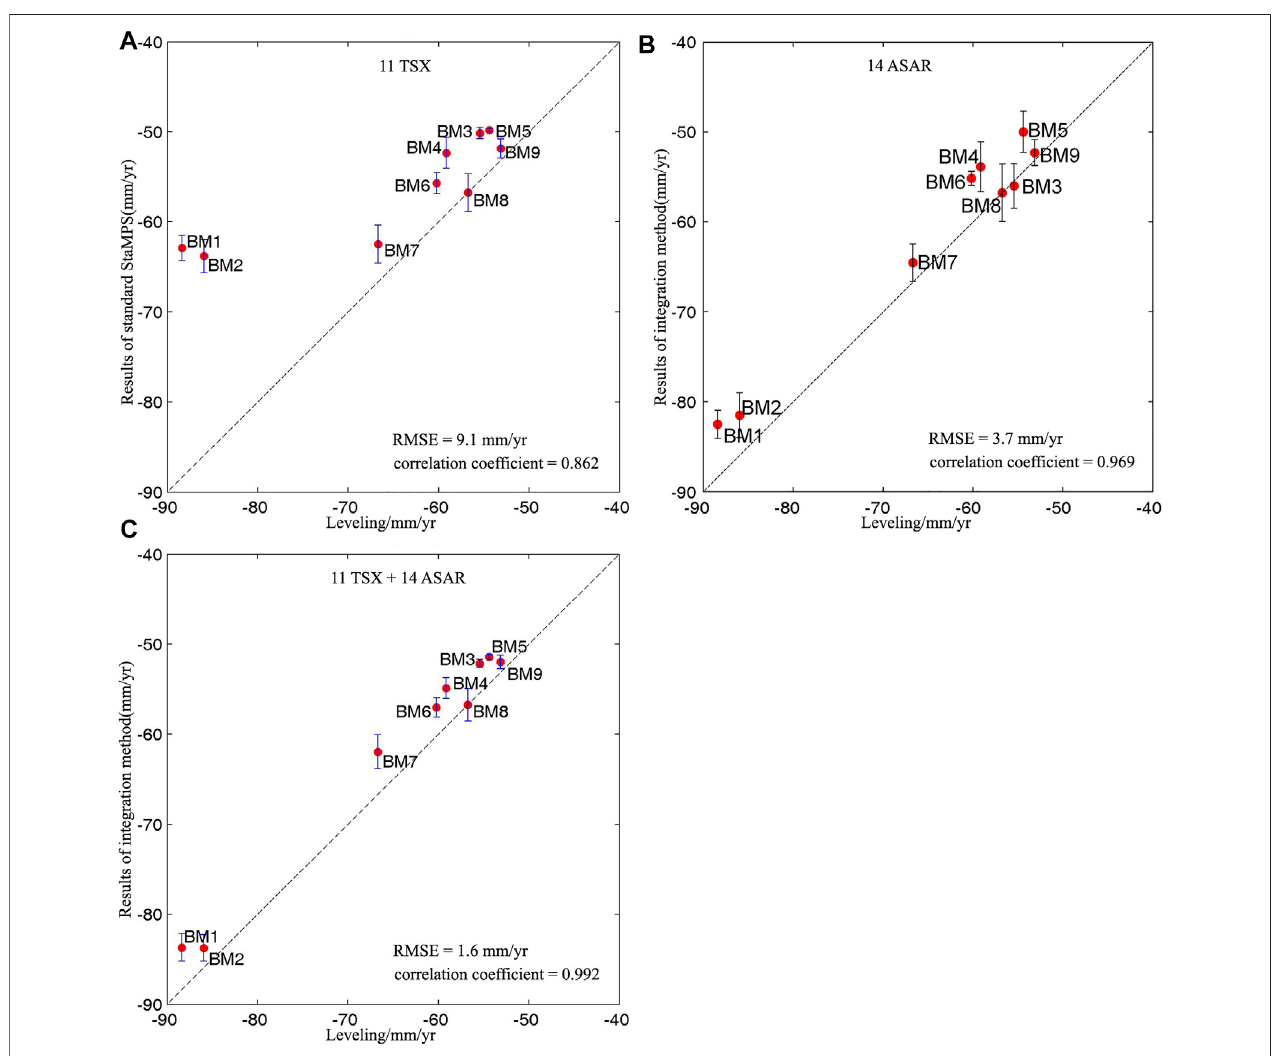
FIGURE 7 | Comparison between deformation rates derived from leveling measurement and (A) 11 TSX acquisitions using standard StaMPS-SB, (B) 14 ASAR acquisitions using standard StaMPS-SB and (C) integration of 11 TSX acquisitions and 14 ASAR acquisitions using the proposed method.